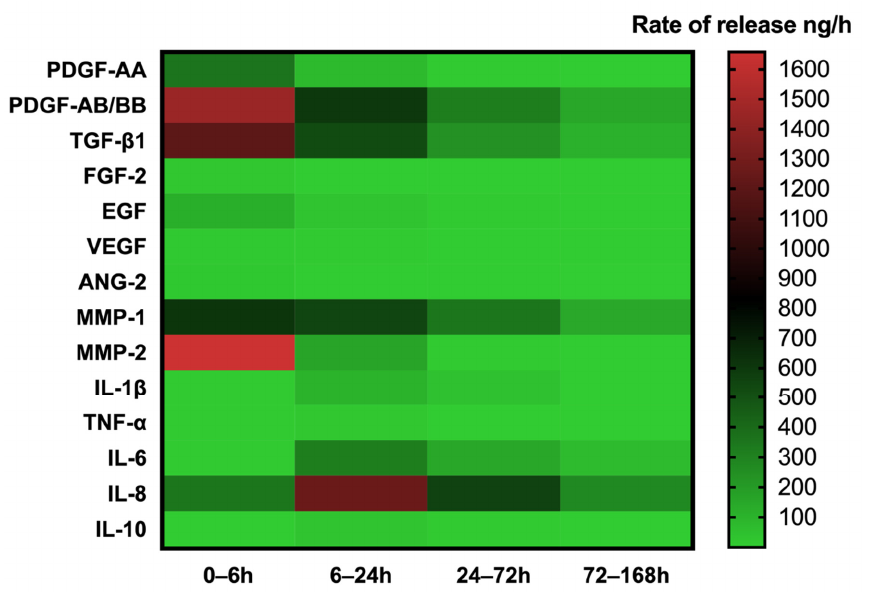
Figure 5. Heatmap of the rate of release of GFs, cytokines, and MMPs up to 168 h. The heatmap represents the changes in the mean of release rate of GFs, cytokines, or MMPs over 168 h. The release rate is indicated according to the color scale representing different levels of rate of release per hour (green—lowest, red—highest rate of release).